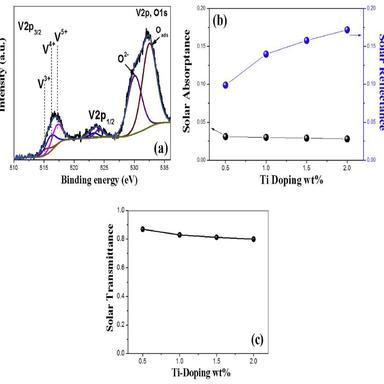
(a) The typical, illustrative, curve fitted V2p and O1s spectra of the as deposited Ti-FVO thin films on the Quartz substrates with 2 wt % of W doping, (b) the average solar reflectance and the average solar absorptance and (c) the average solar transmittance as a function of Ti doping weight percentage in the as deposited Ti-FVO thin films on the Quartz substrates.